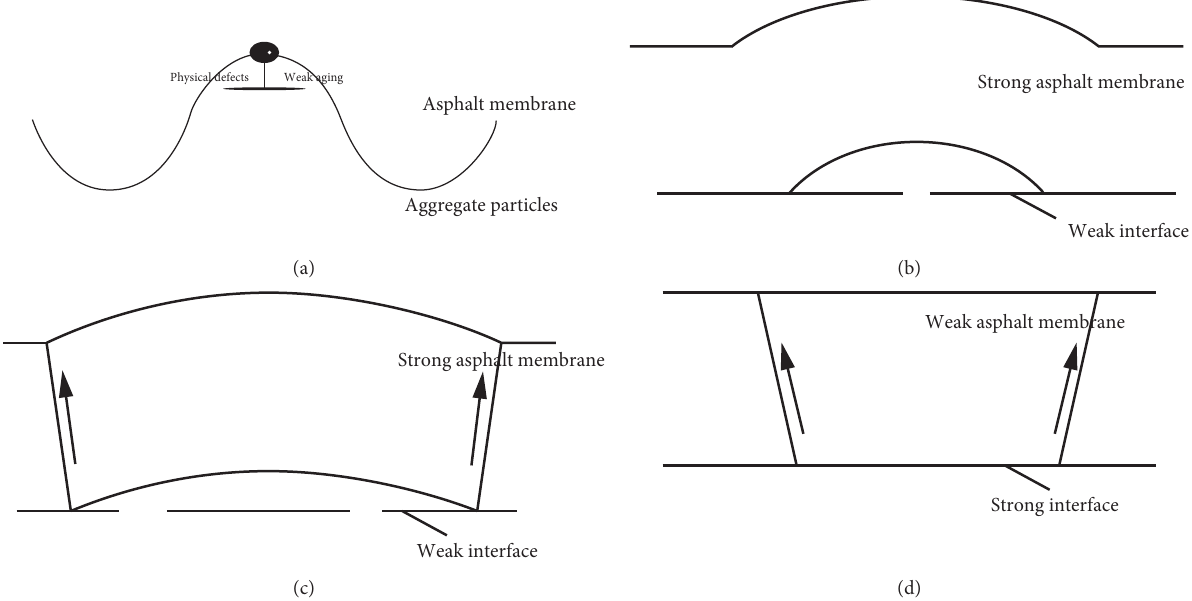
Figure 2: Stripping mechanism of asphalt film under compressive stress. (a) Interfacial crack growth. (b) Asphalt membrane wrinkling. (c) Crack biased growth. (d) Asphalt membrane striping. Table 3: Stripping rate of matrix asphalt in boiling test W b (%).